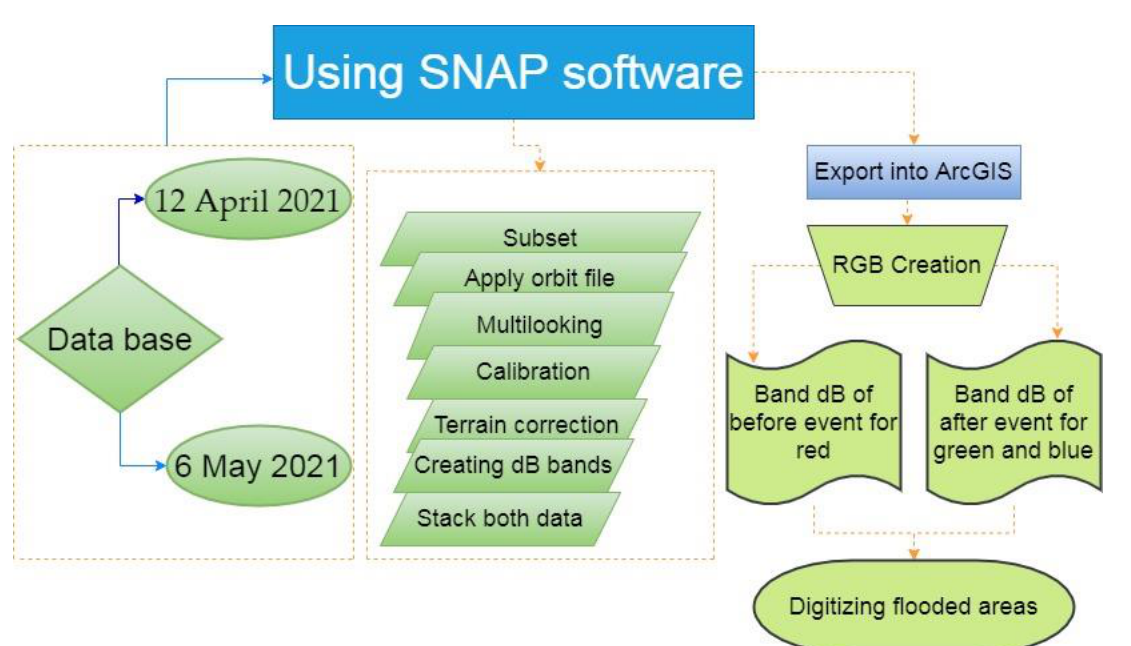
Figure 4. Flow chart for detecting flood points in Tarim city using Sentinel-1 data.